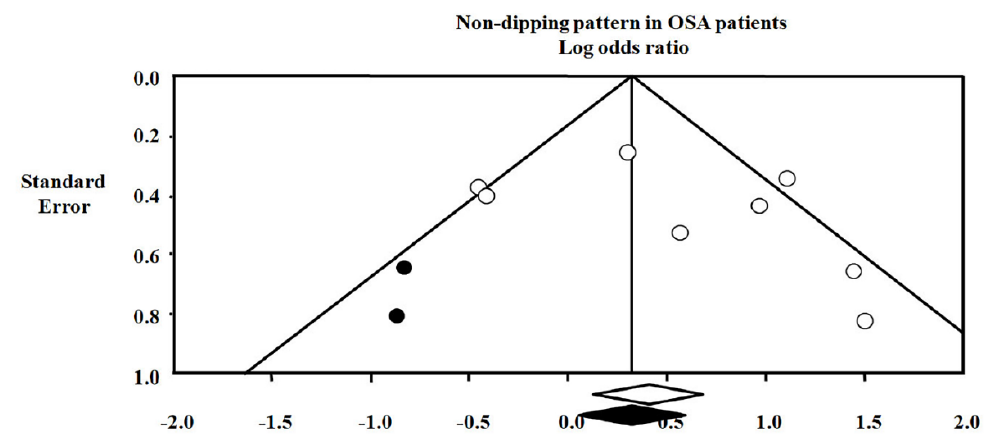
Figure 5. Publication bias of the non-dipping pattern in obstructive sleep apnea OSA patients: Observed odds ratio 1.50 (1.14 – 1.98). Adjusted odds ratio 1.37 (1.05 – 1.79). White symbols refer to observed data. Black symbols refer to adjusted data.